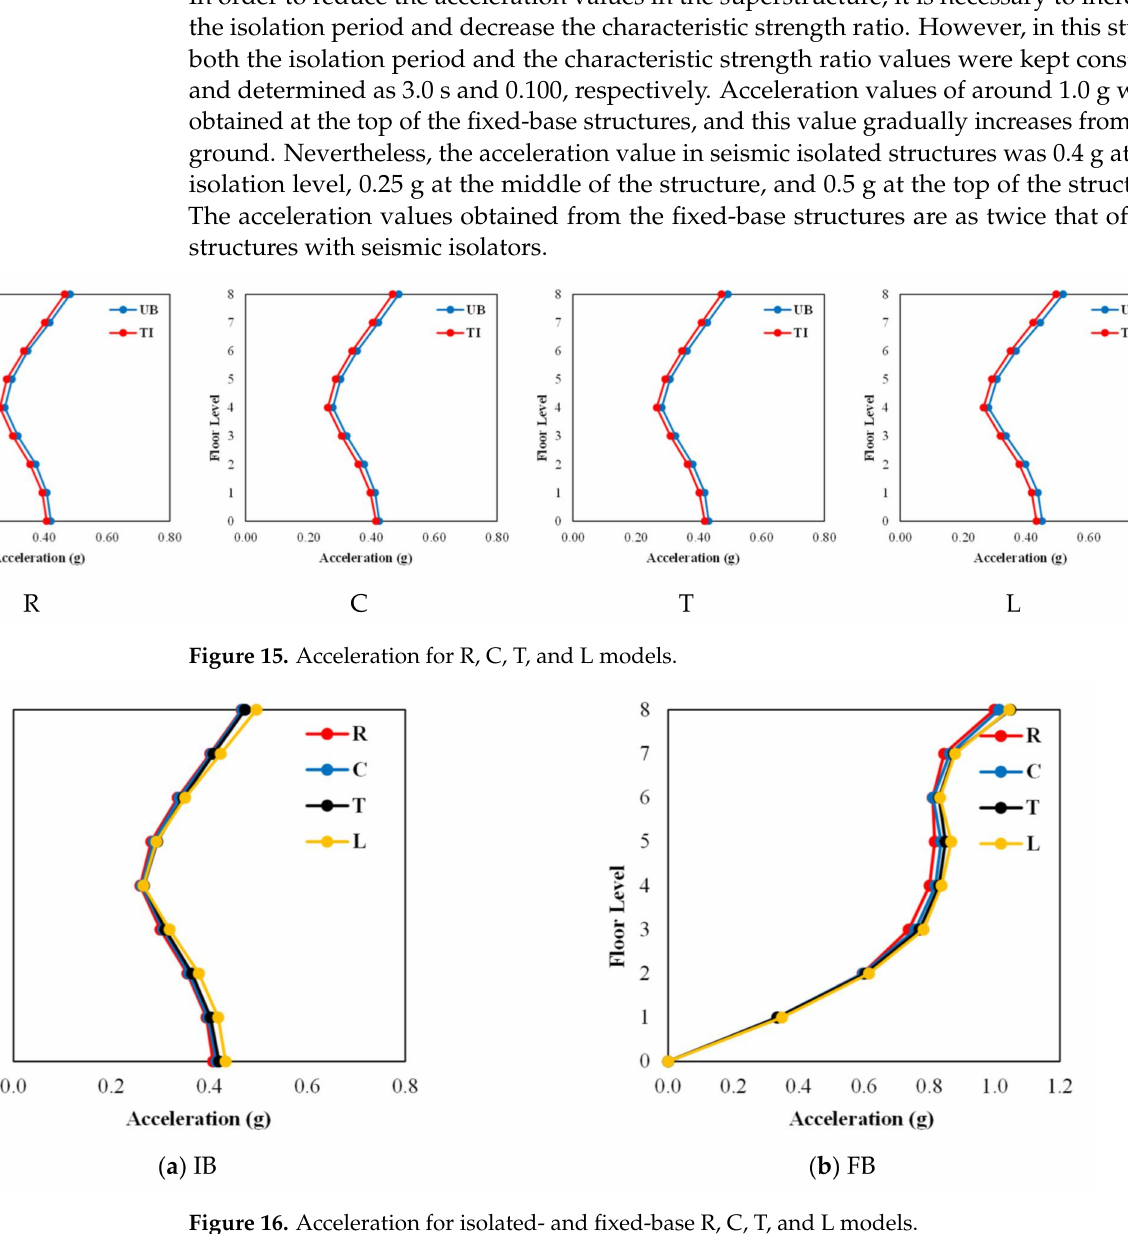
Figure 16. Acceleration for isolated- and fixed-base R, C, T, and L